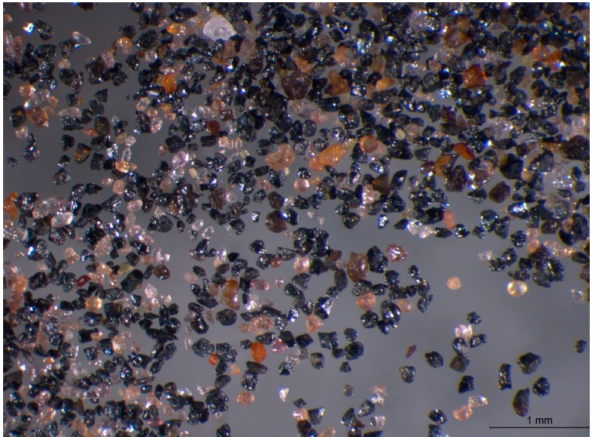
Figure 3. Optical image of Barrytown superheavy fraction.